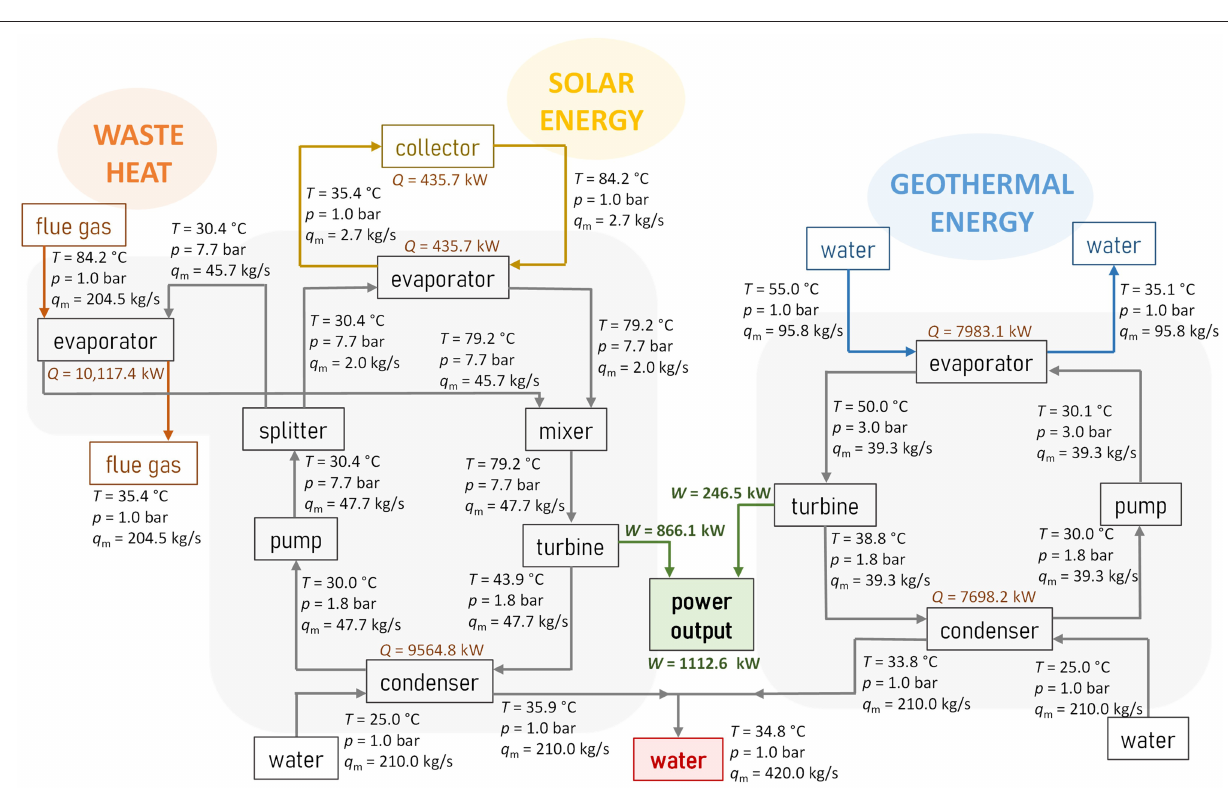
FIGURE 7 | Optimized ORC system when maximizing power output for working fluid